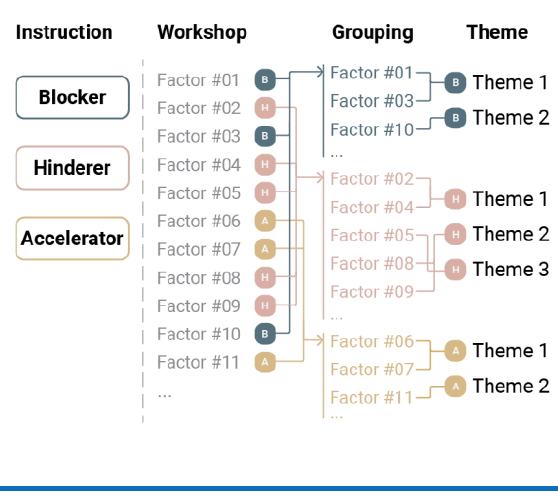
Fig. 1. Data analysis process.